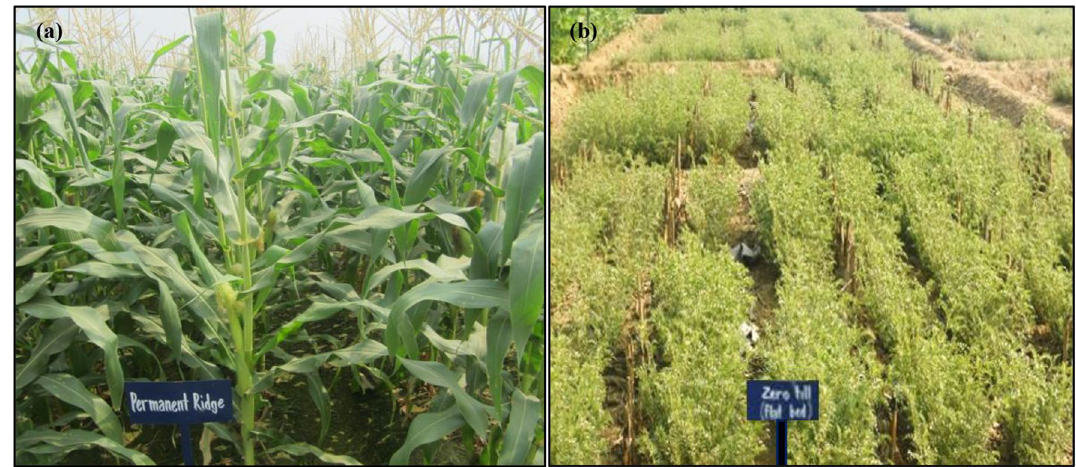
Figure 7. Maize–chickpea rotation under the CA and nutrient management – PNB maize ( a ) and ZTFB chickpea ( b in bands near to the rows (side dressing). Since there is no NE for chickpea, hence, fertilizers were applied as per the RDF in the NE sub-plots. The non-selective herbicide glyphosate at 1 kg ha −1 was sprayed about a week before the sowing of the crops both in the ZTFB/PNB plots. A pre-emergence (2 days after sowing, DAS) atra- zine (maize) and pendimethalin (chickpea) was sprayed; manual weeding’s were done in the CT. Crop protection practices such as pest and disease management were followed as per the requirement of both crops. Irrigation water was applied considering the rainfall pattern coupled with critical crop stages, in which maize crop received three to six irrigations, while for chickpea it was one to two per crop season. Soil sampling and processing. Five soil samples were collected from the 0.0–0.30 m depth (June 2013) for initial analysis, and after harvest of 7th season maize from different soil sections i.e., 0.0–0.10, 0.10–0.20, 0.20–0.30, 0.30–0.40 and 0.40–0.50 m up to 0.50 m depth using the core. The samples were shade dried and ground gently using the wooden pestle and mortar, sieved in a 2 mm sieve, and stored in the air-tight polythene for further analysis of soil properties. For soil MBC analysis, the moist soil samples were collected using the tube